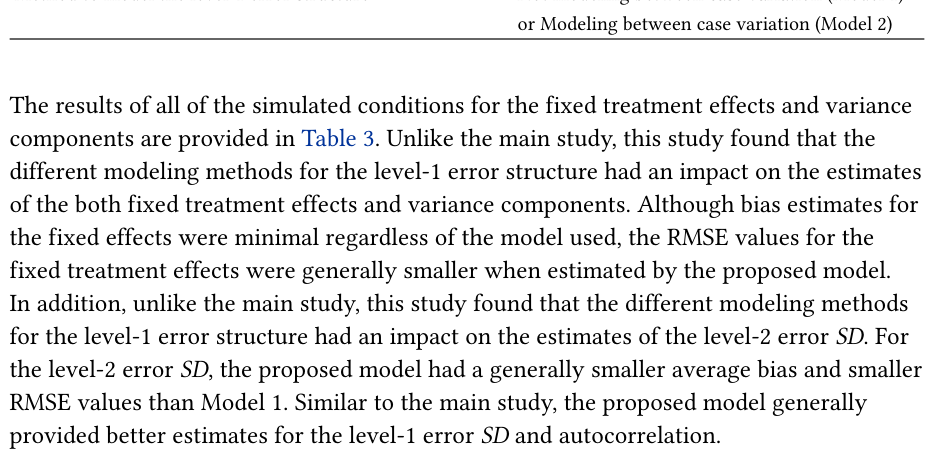
Autocorrelation .2 and .4 or .4 and .2 Combination of number of cases and series length per case 4 and 10 or 8 and 20 Method to model the level-1 error